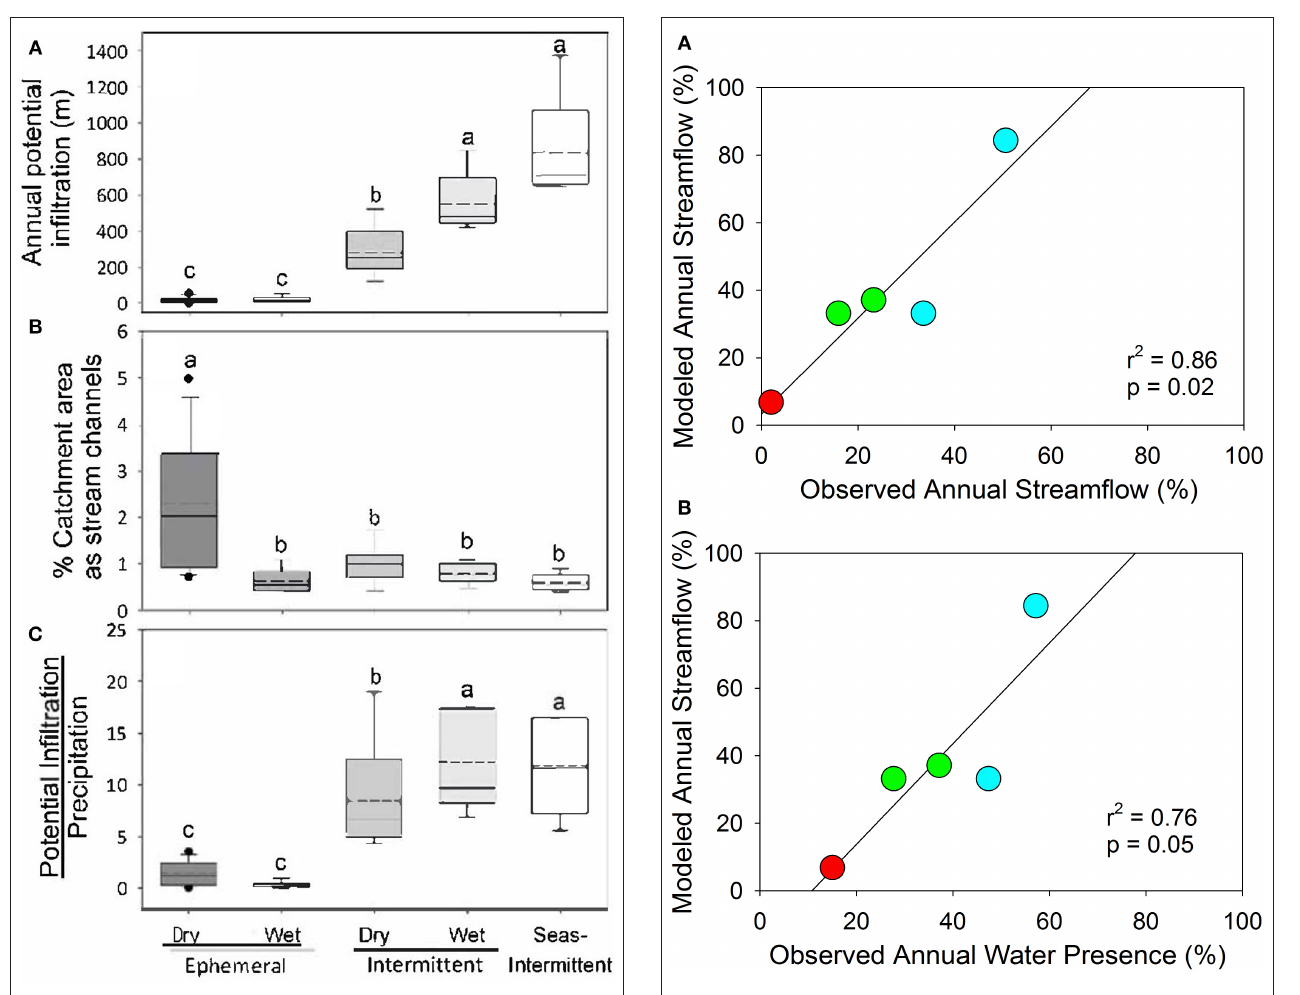
FIGURE 8 | Box plots of (A) Annual infiltration depth for each flow cluster; (B) percent of catchment that is comprised of stream channels and (C) ratio of total annual potential infiltration to precipitation assuming that the entire stream channel bed contributes to infiltration. Box plots dashed lines denote means, solid lines denote medians. Boxplots with distinct lowercase letters have significantly ( p < 0.05) different means.